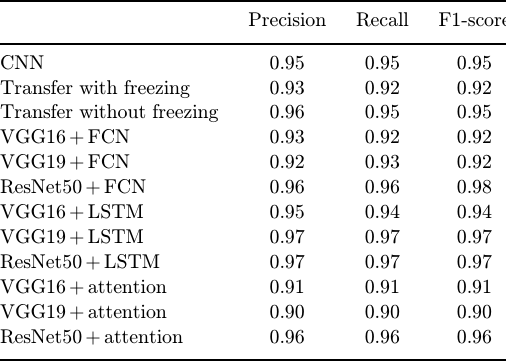
Table 8. Overall classi¯cation report of the